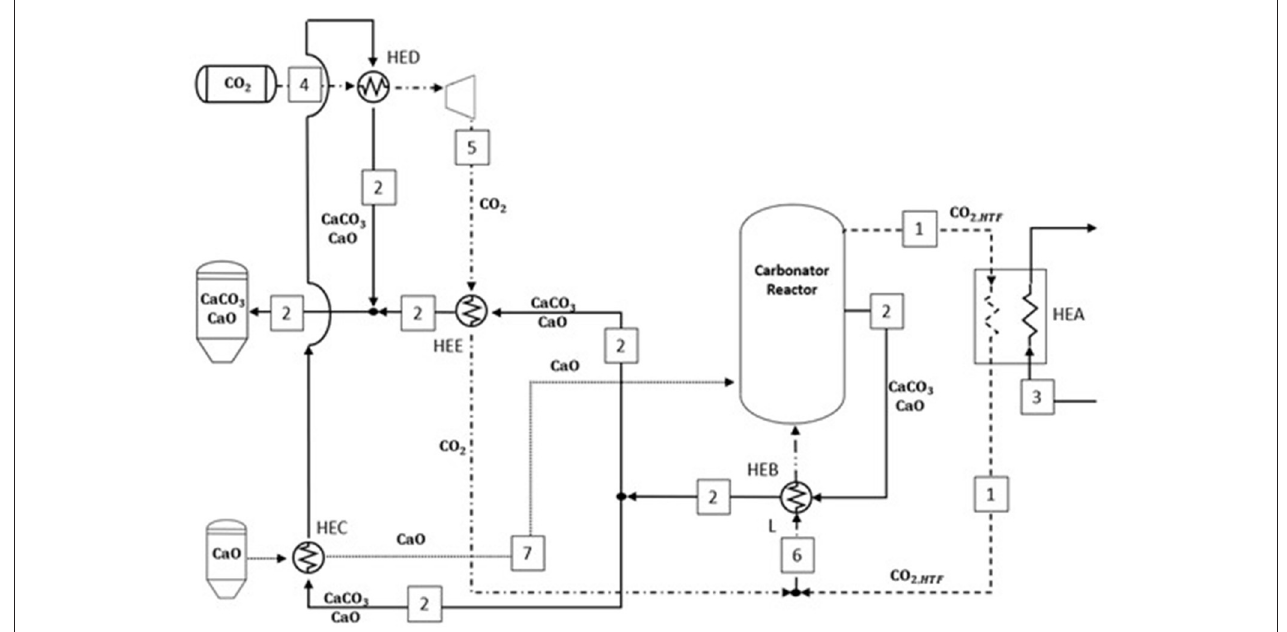
FIGURE 6 | Minimum energy consumption network inferred from the pinch analysis on the carbonator side. The plant configuration results from the pinch analysis optimization.